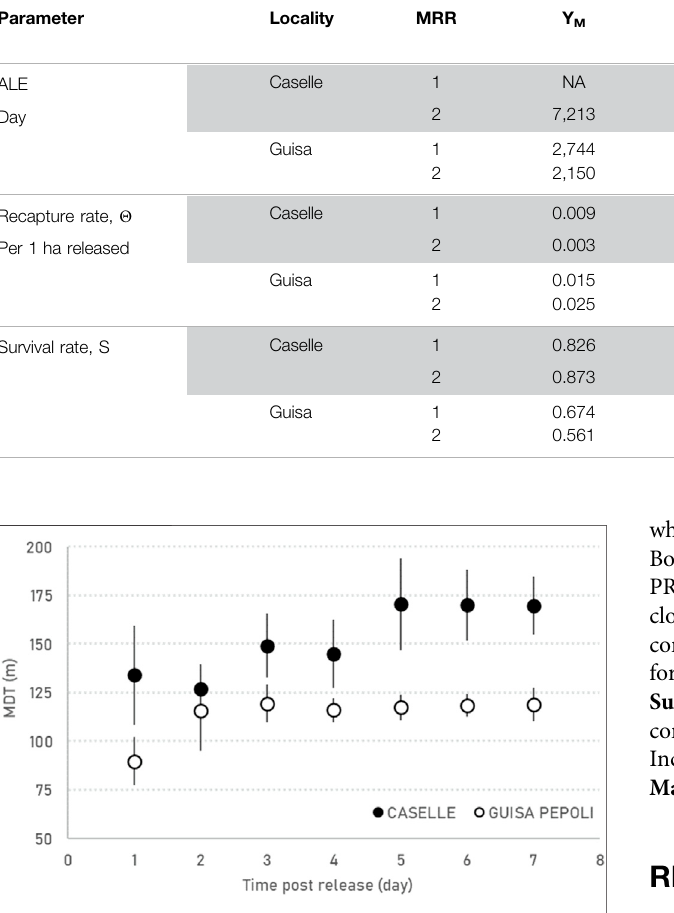
FIGURE 3 | Daily mean (±SE) distance traveled (MDT) by sterile marked males recorded in the MRR trials in Caselle and Guisa Pepoli.